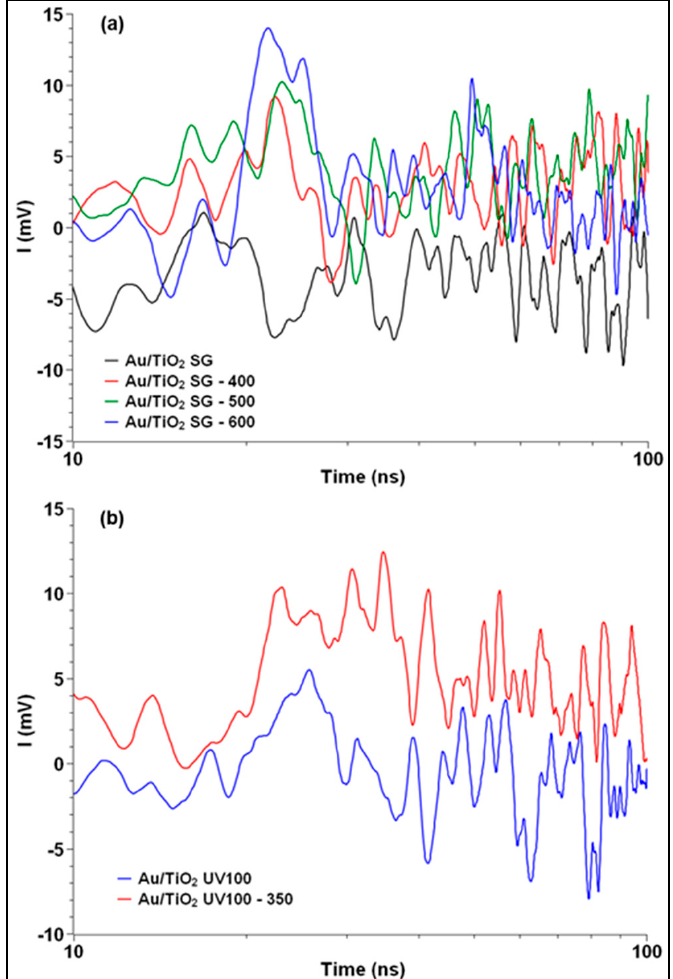
Figure 8. TRMC signals at 450 nm obtained on ( a ) Au/TiO 2 SG-X and ( b ) Au/TiO 2 UV100-350 commercial-based samples.